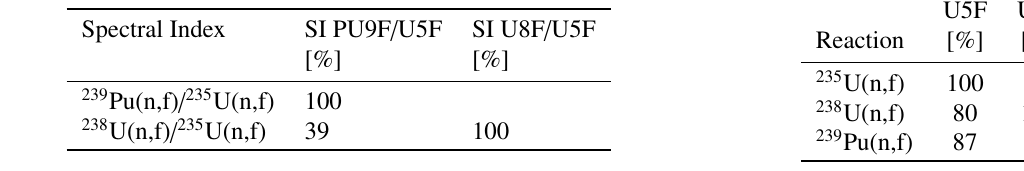
Table 9: Experimental correlations for Davis et al. [26].